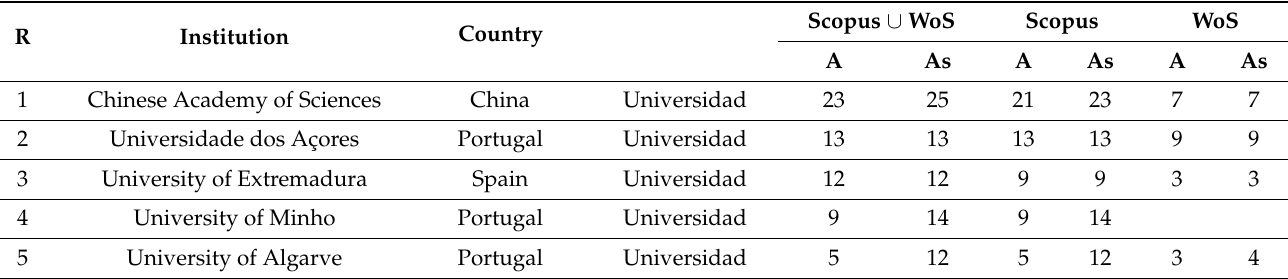
Table 8. Most productive institutions with authors and authorships.